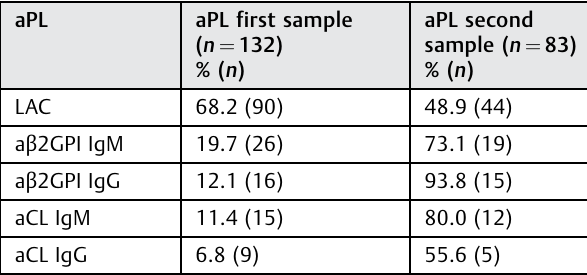
Table 7 aPL determination in 132 aPL-positive patients at fi rst determination (at time of event) with additional